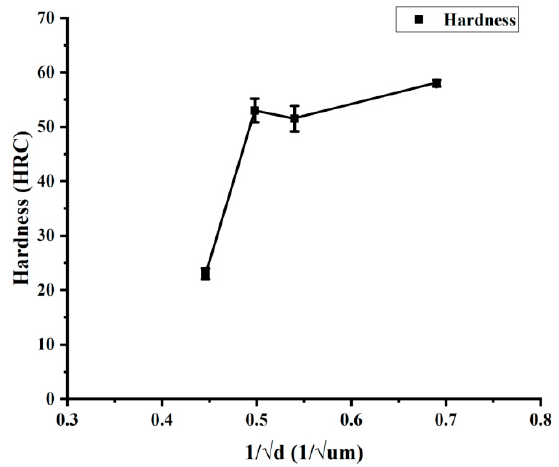
Figure 6. Hall-Petch curve showing the relationship between hardness and average grain size.